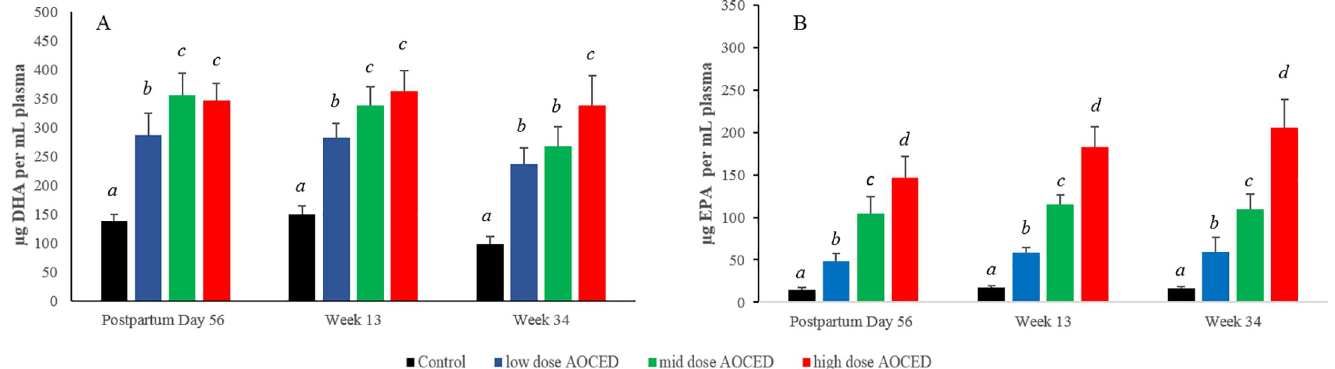
Fig 6. Plasma DHA (A) and EPA (B) levels in puppies (combined genders). Values are given as Mean + SD and expressed as μ g/mL, n = 8 in each group. a , b , c , d signify between-group differences at a timepoint (p < 0.05).